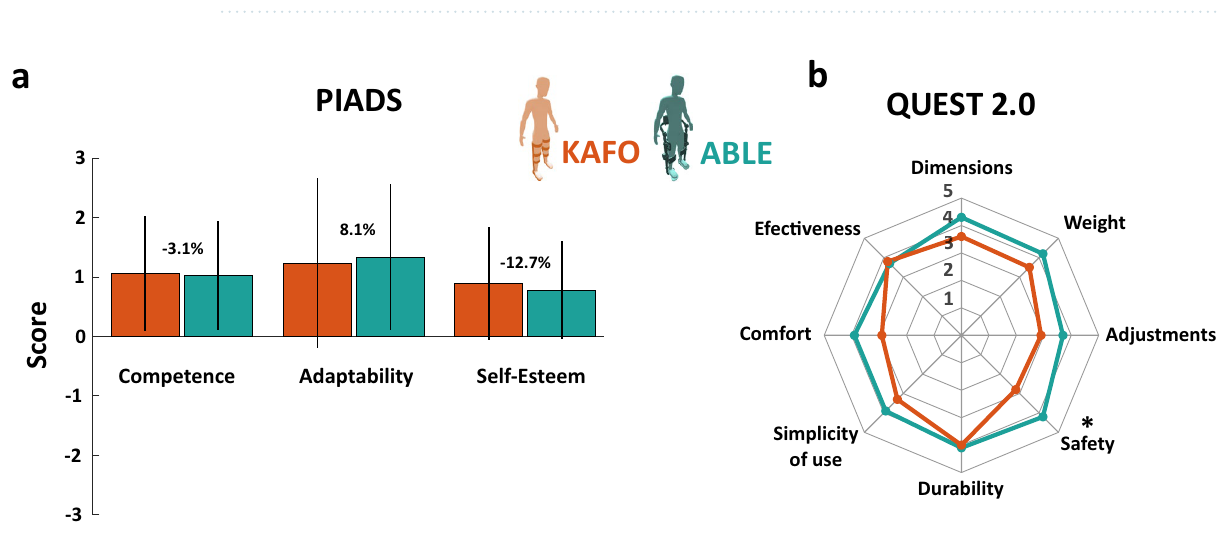
Figure 6. ( a ) Scores of the three subscales of the PIADS questionnaire for each device. Scores range from − 3 (maximum negative impact) to zero (no perceived impact) to +3 (maximum positive impact). ( b ) First 8 items of the QUEST 2.0 questionnaire for each device. These items assess characteristics of the corresponding device in terms of the shown dimensions. Answers are categorized on a five-point scale that ranges from 1 (not satisfied at all) to 5 (very satisfied). Stars (*) indicate statistically significant differences ( p < 0.05